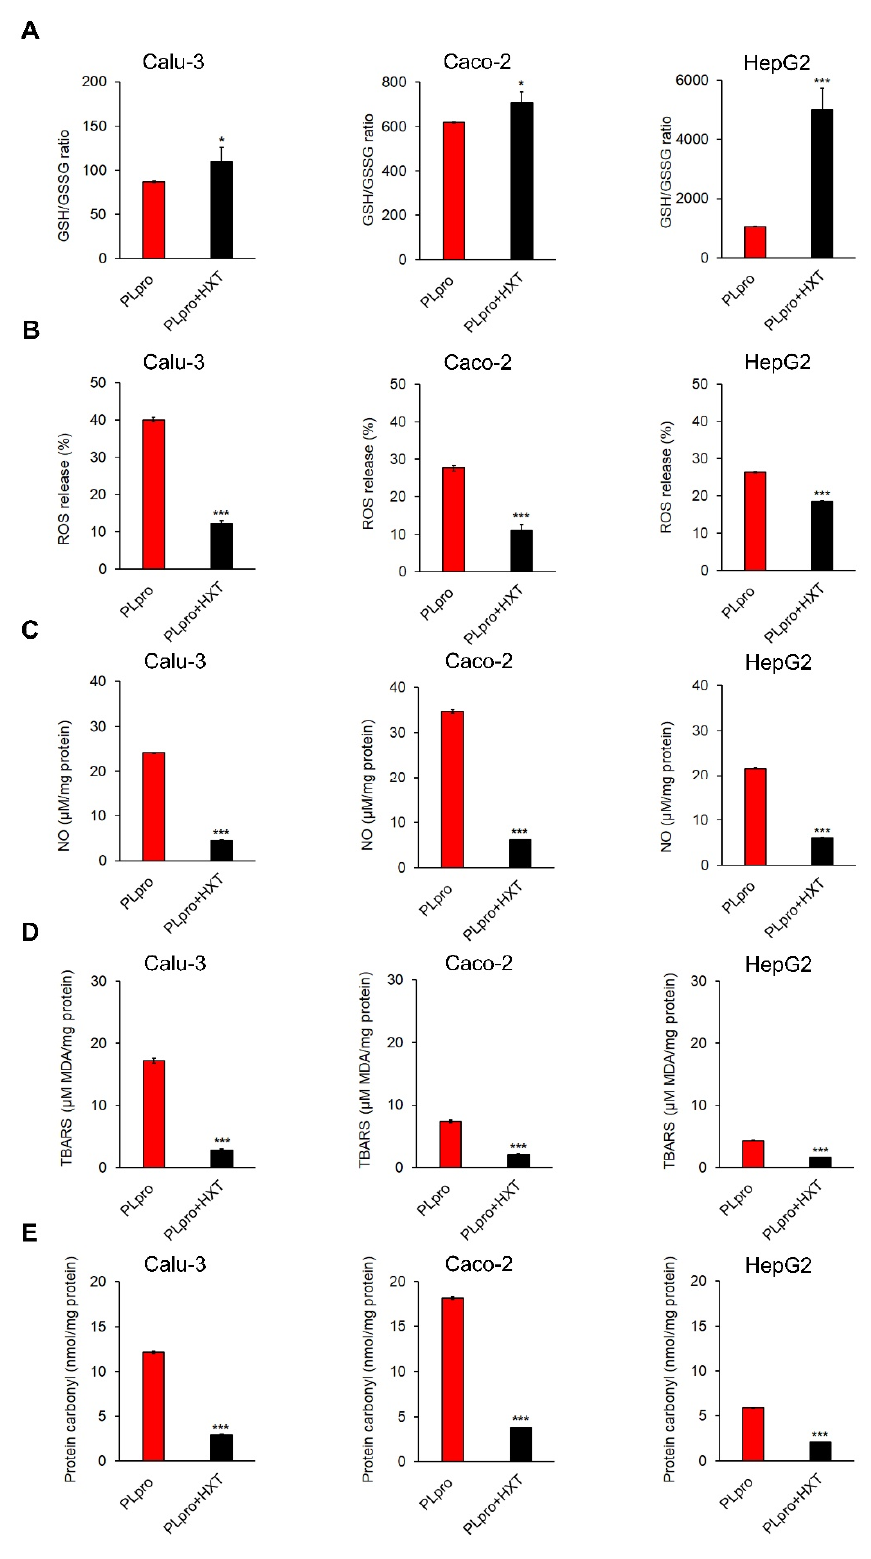
Figure 7. Treatment with HXT reduces PLpro-dependent pro-oxidant response in epithelial cells. The histograms report GSH/GSSG ratio ( A ), percentage of ROS release ( B ), and levels of NO ( C ), TBARS ( D ) and protein carbonyl ( E ) in Calu-3, Caco-2 and HepG2 cells expressing PLpro, before and after treatment with 10 μ M HXT for 24 h. Values are plotted as mean ± SD of two independent experiments repeated in duplicate. Data were analyzed by 2-tailed t -tests, * p < 0.05, *** p < 0.001 vs. PLpro.